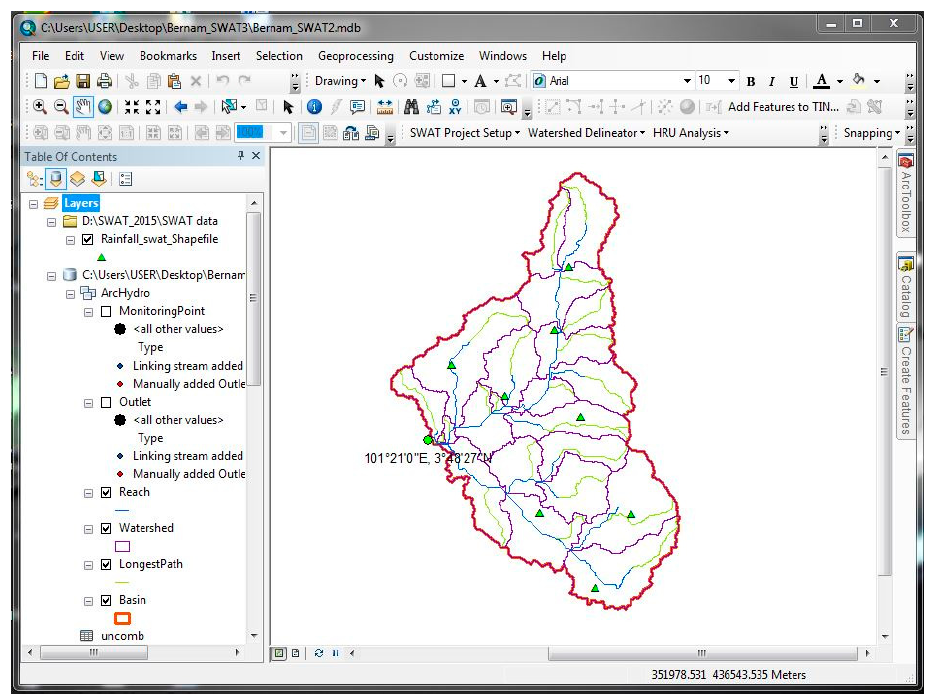
Figure 3. Bernam watershed delineation process in the SWAT model.